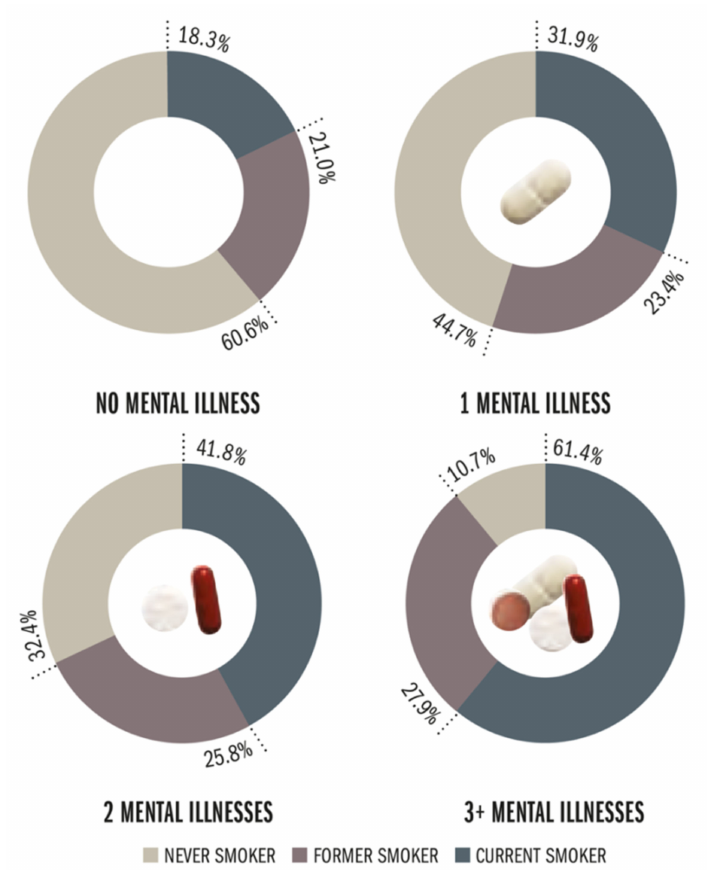
Figure 4. Prevalence of smoking among people with lifetime mental illnesses or psycholog- ical distress, comprising bipolar disorder, dementia, schizophrenia, phobias/fears, attention deficit/hyperactivity, and serious psychological distress. Prevalence of current smoking increased with higher numbers of mental illness, ranging from 18.3% for subjects with no illness to 61.4% for subjects with three or more mental illnesses. Reused from The Tobacco Atlas, 5th edition with permission. Copyright ©2015 The American Cancer Society, Inc.